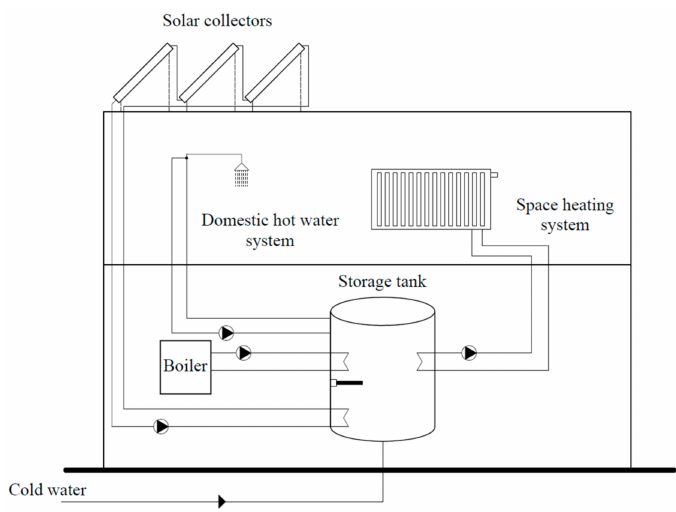
Figure 1. Scheme of a solar hot water system used for SH and DHW